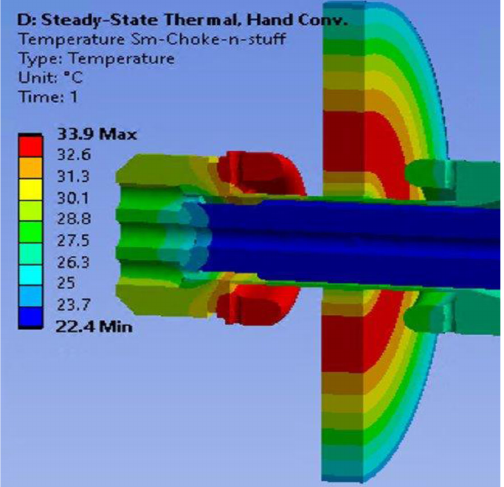
FIG. 14. Temperature profile on choke area.